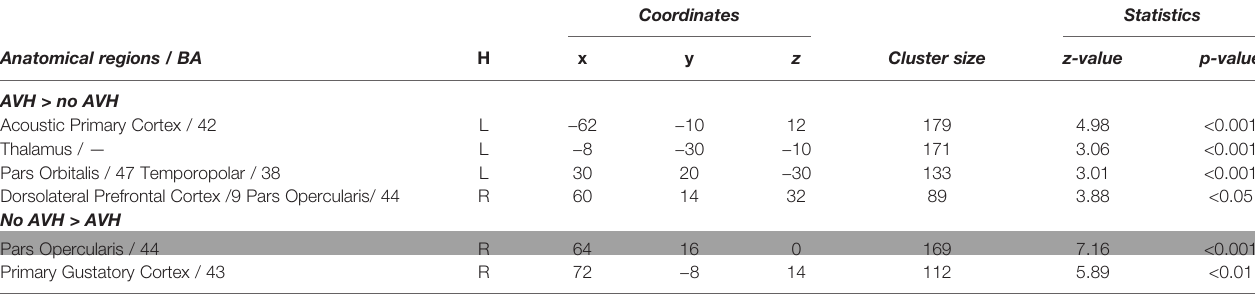
TABLE 1 | Results of the analyses of BOLD responses for the contrasts (AVH > no AVH) and (no AVH > AVH).